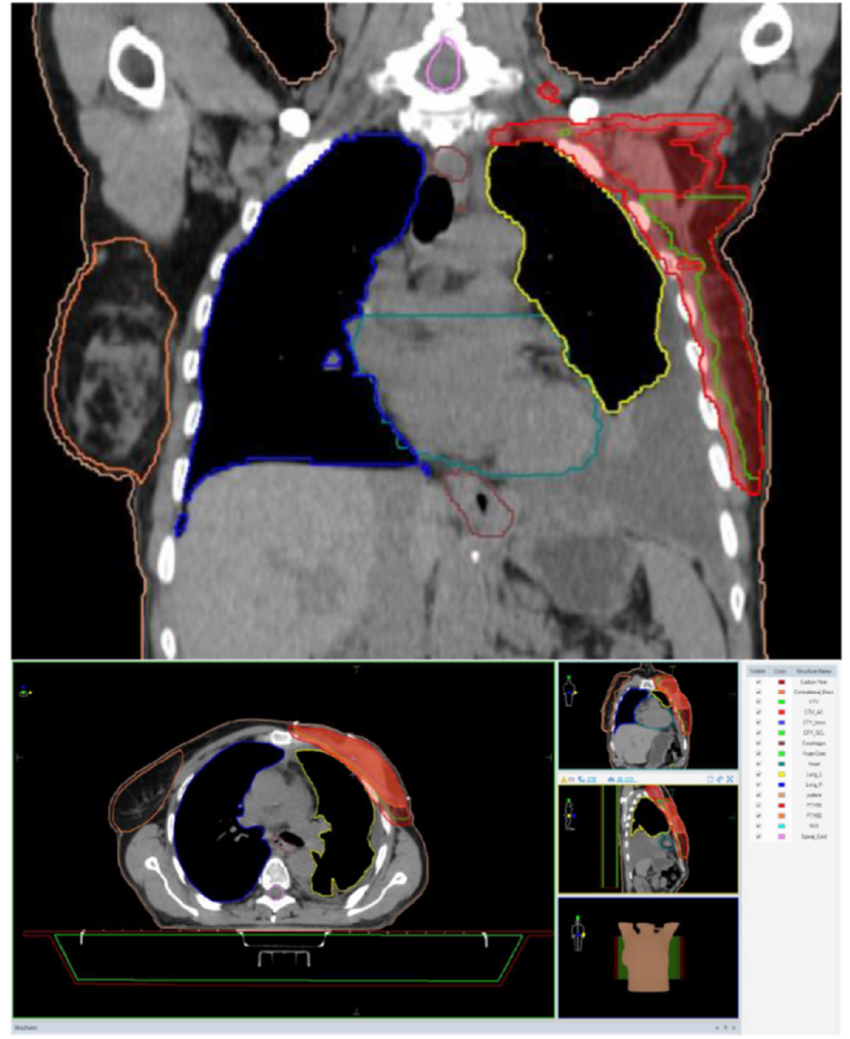
Figure 4. Radiation treatment planning.